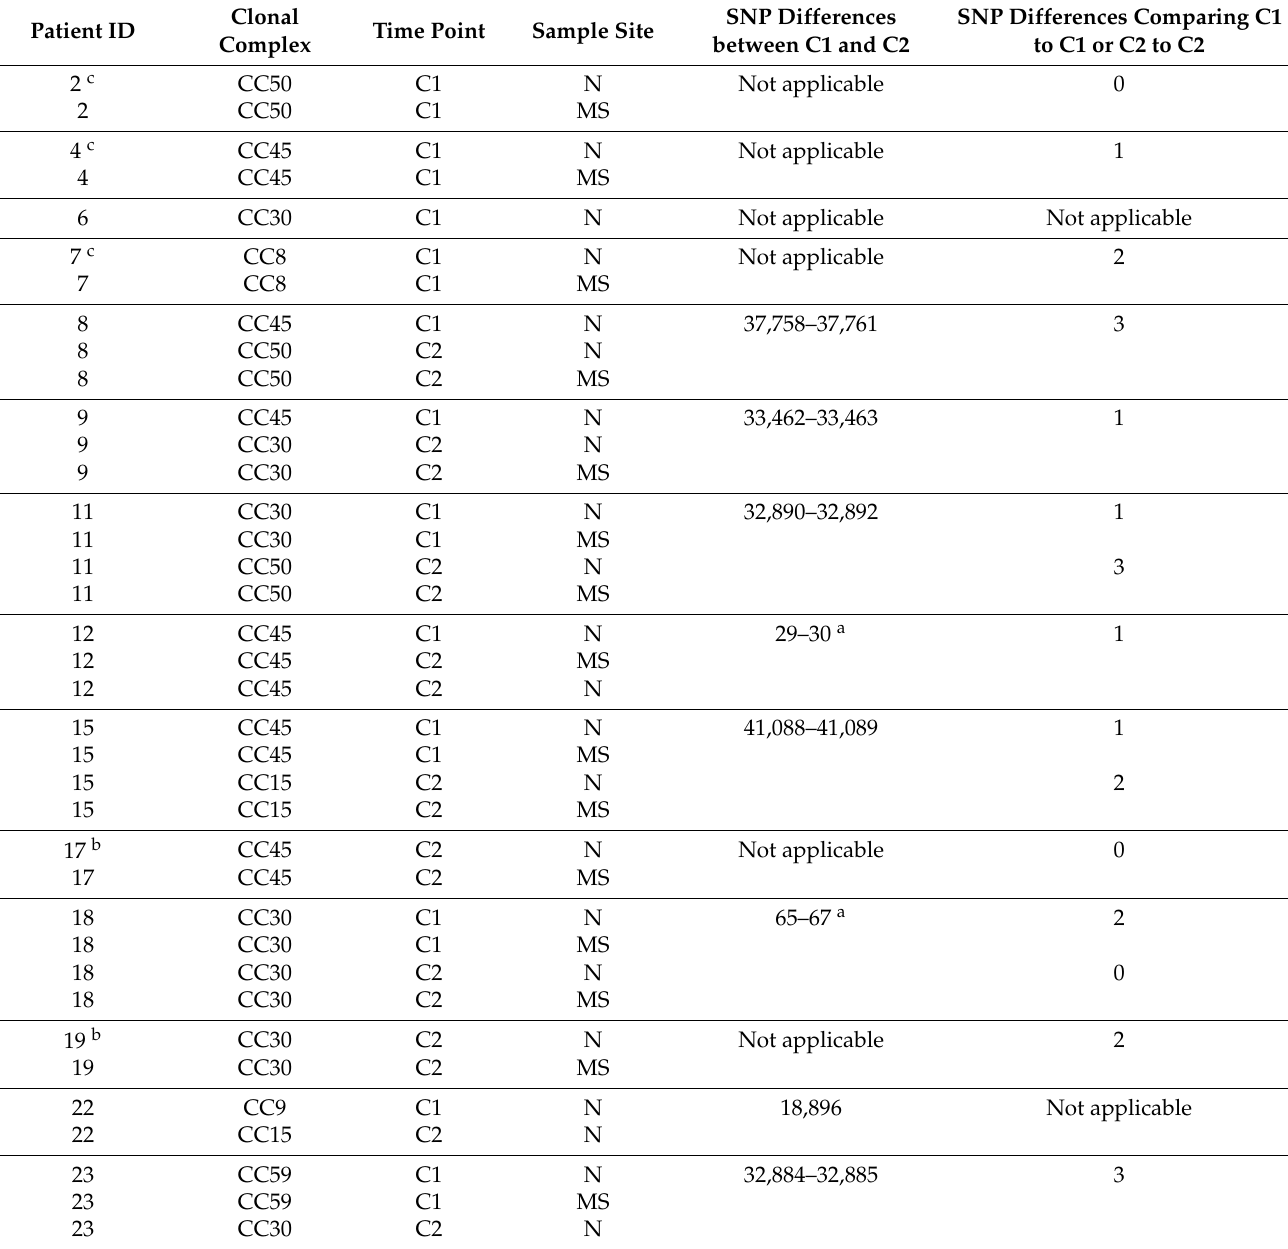
Thirteen different CCs were found and the most prevalent CCs among the isolates were CC30 (27%, 18/66) and CC45 (20%, 13/66); details are given in Table 1. These findings are illustrated using a midpoint rooted phylogeny showing the clustering of isolates according to sequence types and clonal lineages (Figure 2). Genes encoding cell- wall-associated proteins (IsaA, Plc, Efb-C, and SCIN) were present in all isolates. One isolate was lacking the gene (scn) encoding SCIN. The tst-1 gene was only present in 24% of isolates, and lukF-PV was absent from all isolates. Table 1. Single-nucleotide polymorphisms (SNPs) detected between the S. aureus isolated at both sample sites at initial collection (C1) and/or after 8–15 years (C2; mean follow-up: 11 years) based on a conserved core genome of ~2.23 Mbp across the collection. Sample site: maxillary sinus (MS), nares